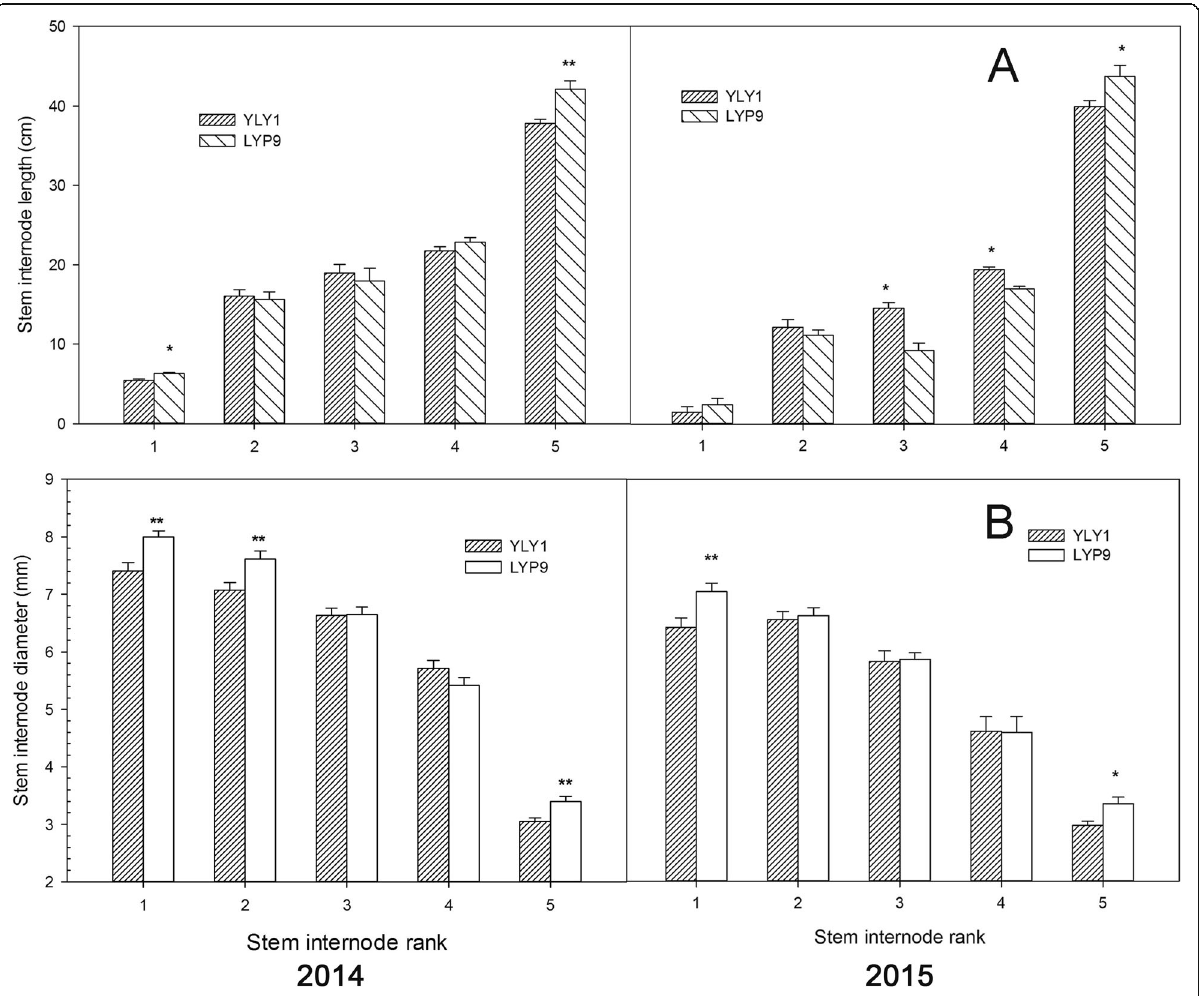
Fig. 6 The length and diameter of stem internode for YLY1 and LYP9 at the Yellow ripe stage in 2014 and 2015. “ *, ” “ ** ” represent significance levels of p = 0.05 and p = 0.01 levels, respectively. The bar represents the standard deviation of 5